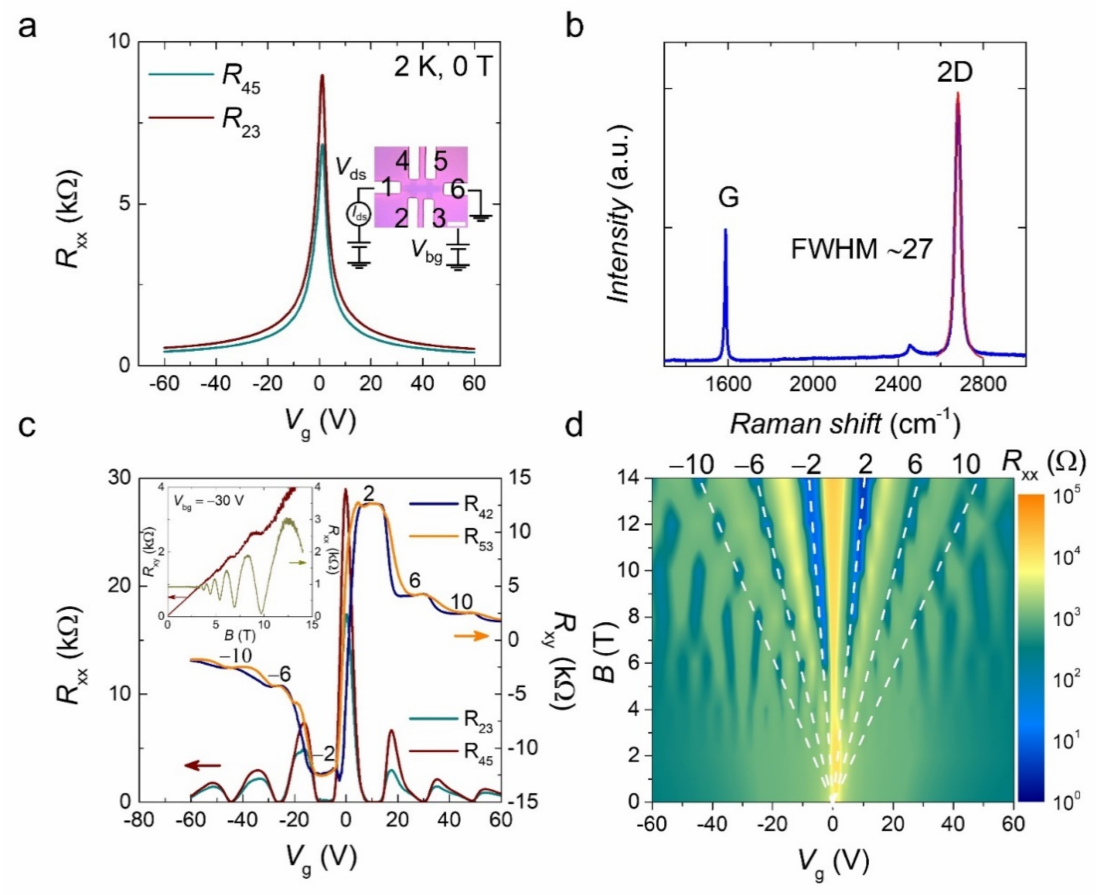
Figure 1. Single-crystal monolayer chemical vapor deposition (CVD) graphene device (D1) and its quantum Hall (QH) state. ( a ) Longitudinal resistance ( R xx ) at zero magnetic field and 2 K with an applied voltage of V ds = 100 mV. The inset is the optical microscopy image of the device. The scale bar is 5 µ m. ( b ) Raman spectra of monolayer graphene. The fitting of 2D peak is indicated by red line. ( c ) Gate voltage ( V g ) dependence of R xx ( R 42 , R 53 ) and Hall resistance ( R xy ) ( R 23 , R 45 ) measured at 2 K and 14 T with an applied current of I ds = 1 µ A. The inset shows magnetic field dependence of R xx and R xy measured at V bg = − 30 V. ( d ) Landau fan diagram of R xx as a function of V g and magnetic field B ; the white dashed lines are guides for the eye for Landau levels (LLs) with filling factors ν = ± 2, ± 6, and ±